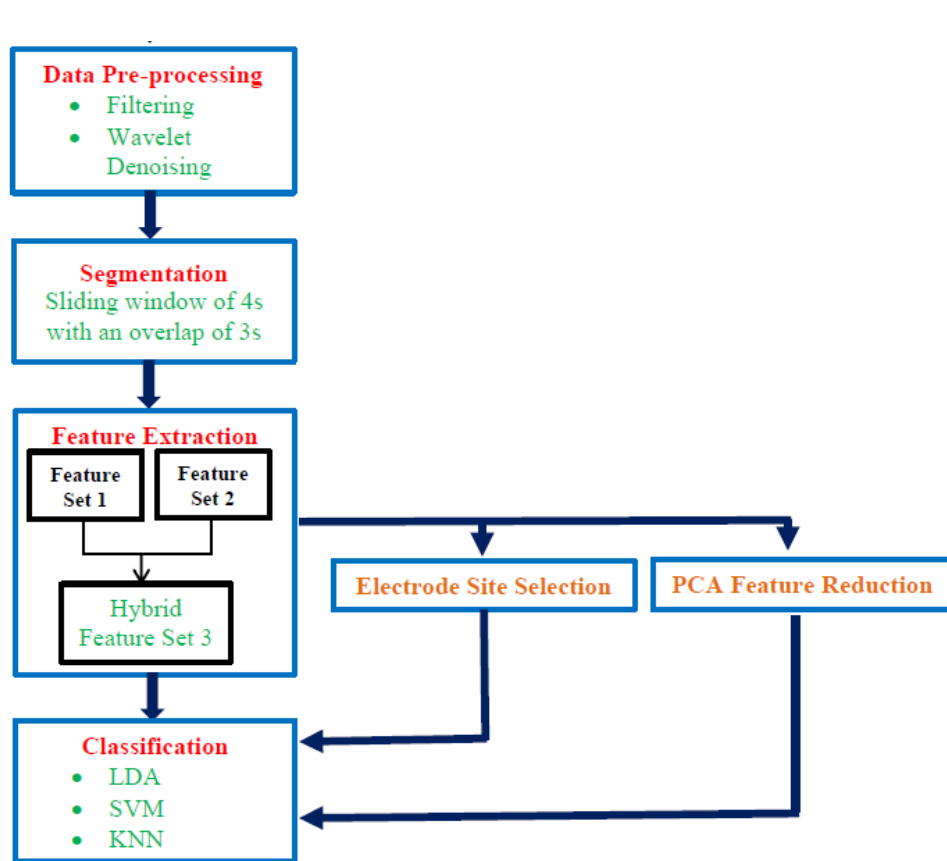
Figure 2. Block diagram of the proposed system .